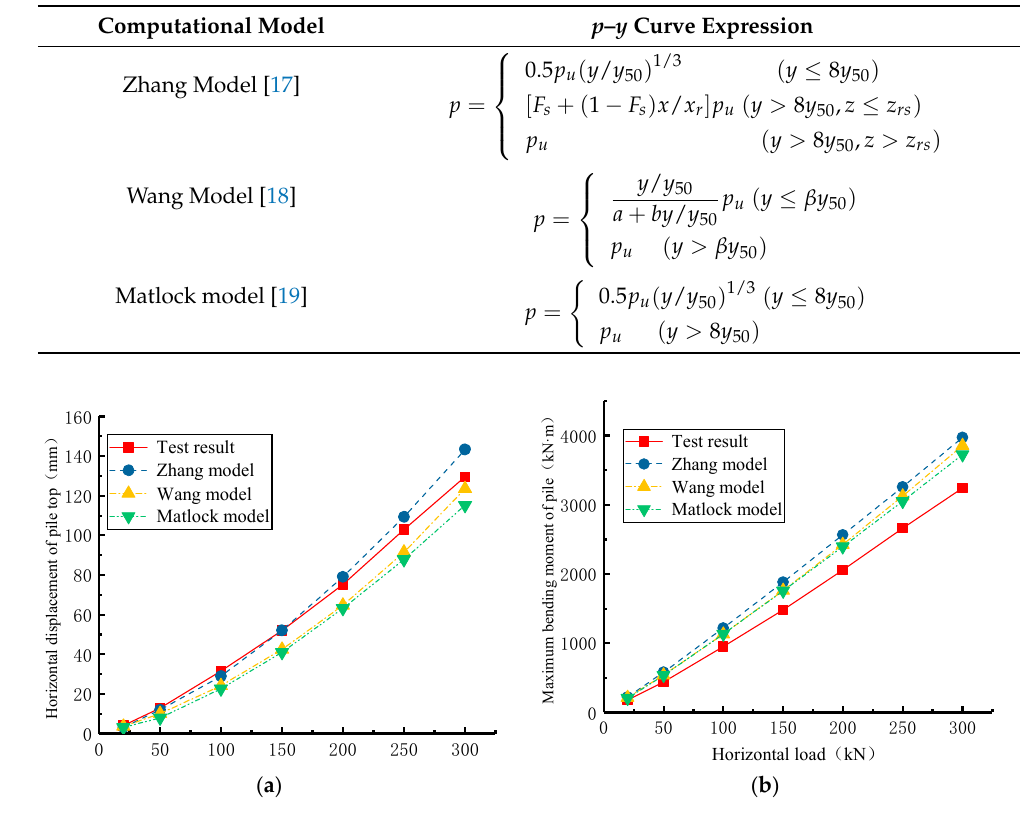
Figure 6. Test and calculation results of different p – y curves. ( a ) Horizontal displacement of the pile top; ( b ) maximum bending moment of the pile shaft.